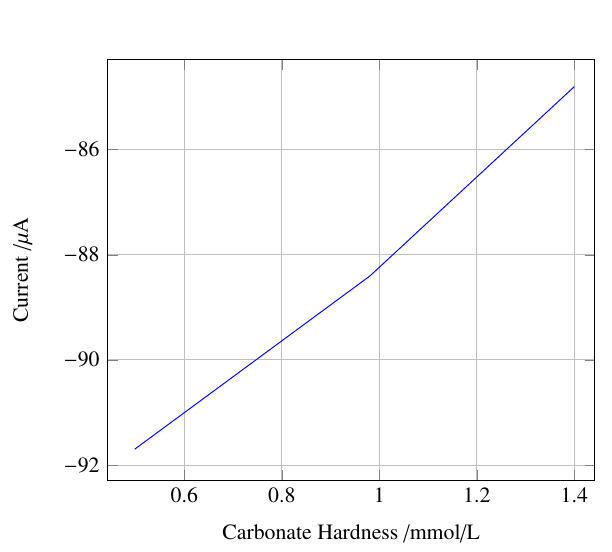
Figure 6. Impedance spectra of water samples with the same total hardness and di ff erent carbonate hardness.